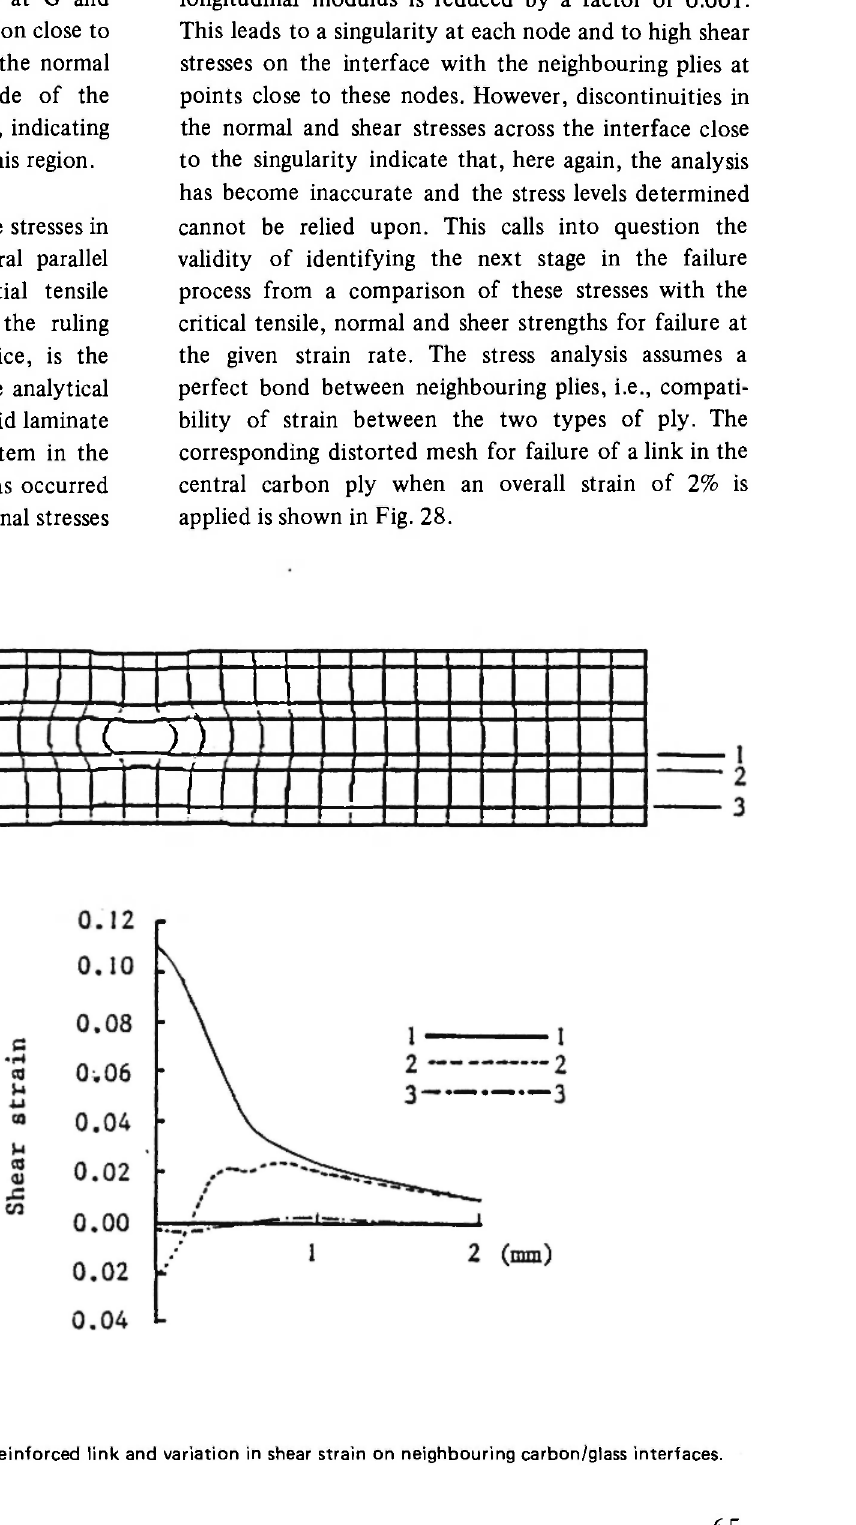
Fig. 28: Distorted mesh around a failed carbon-reinforced link and variation in shear strain on neighbouring carbon/glass